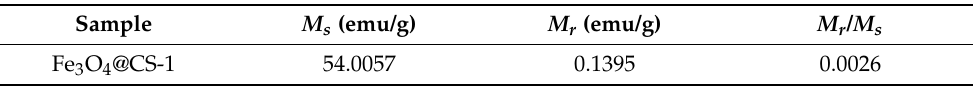
Table 1. Magnetic properties of Fe 3 O 4 @CS-1. M s is the saturation magnetization, and M r is the remanence magnetization.